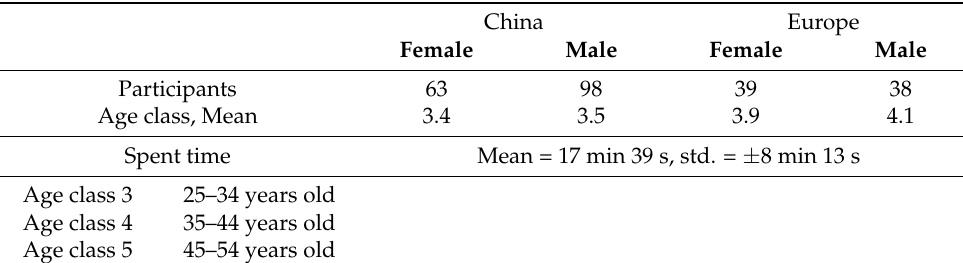
Table 3. Demographics of survey attendances.